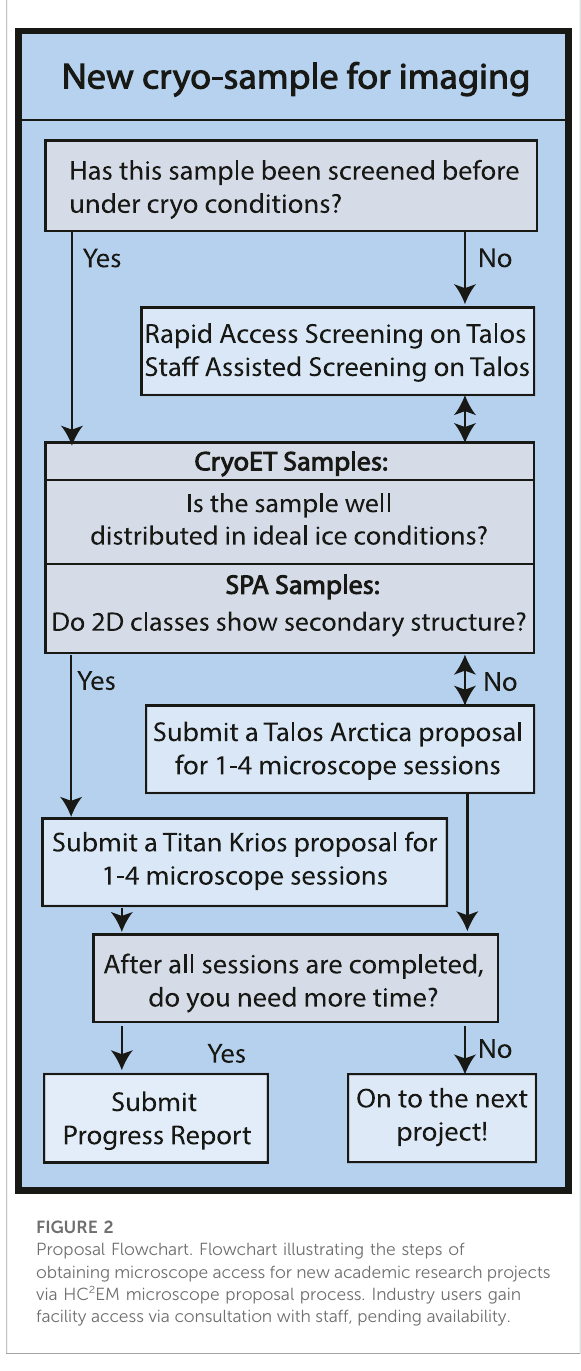
FIGURE 2 Proposal Flowchart. Flowchart illustrating the steps